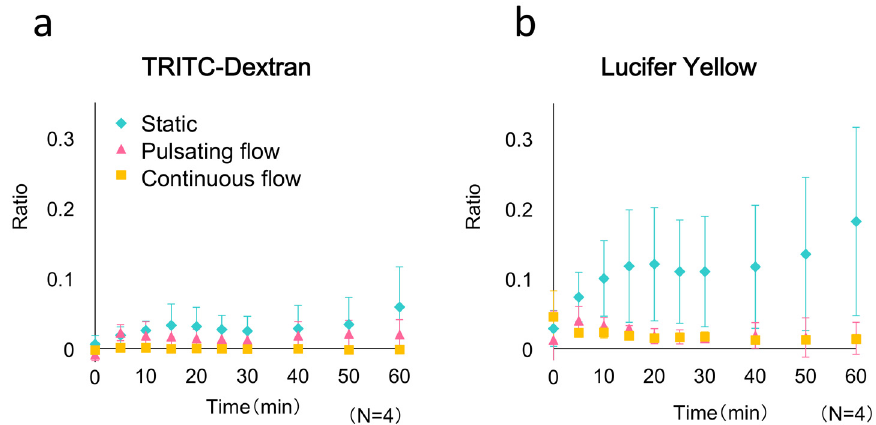
Fig 4. Permeability measured using the microfluidic system containing BECs and LECs cultured under 3 conditions. Permeability tests were performed after cells were cultured for 24 h (BEC-LEC coculture) under a 1- μ L/h pulsating-flow condition generated using a miniaturized infusion pump (pink triangles), a 1- μ L/h continuous-flow condition generated using a syringe pump (yellow squares), or the static condition (blue diamonds). The values are presented as means ± SD. The fluorescent tracers used were (a) TRITC-dextran and (b) Lucifer Yellow. The significance of differences between the 60-min values was assessed by performing t tests: (a) P < 0.05, between static condition and continuous-flow condition; and (b) P < 0.05, between static condition and both flow conditions. Each data point was obtained from four devices (n = 4).